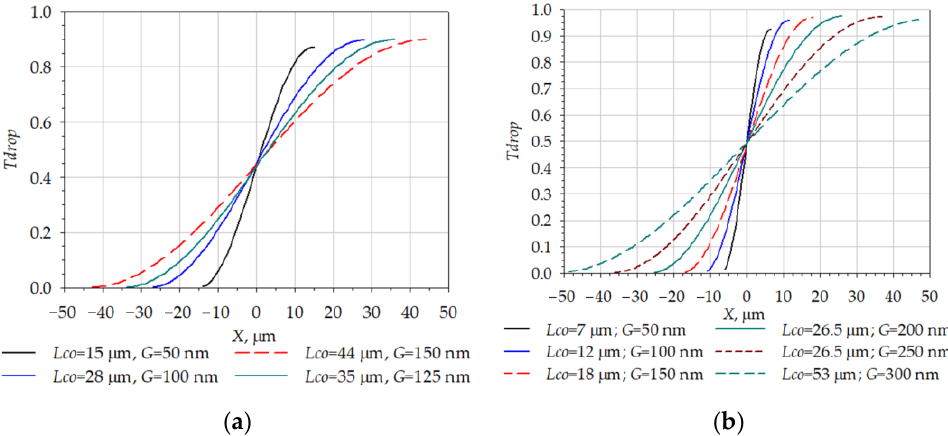
Figure 10. Dependence of the optical transmission coefficient on the inertial mass displacement along axis X for the OMT with single-plane waveguides (Scheme 2). ( a ) Waveguides with dimensions of 300 × 1000 nm; ( b ) Waveguides with dimensions of 300 × 750 nm.